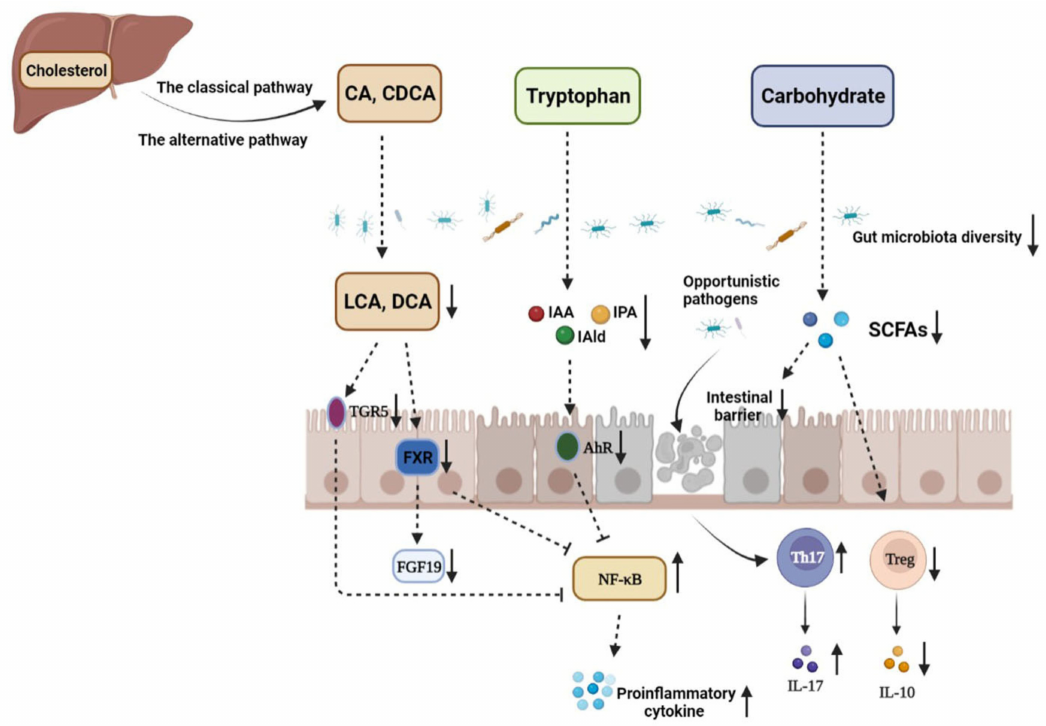
Figure 1. The disturbance of gut microbiota and microbiome metabolites in the pathogenesis of IBD. CA: cholic acid; CDCA: chenodeoxycholic acid; LCA: lithocholic acid; DCA: deoxycholic acid; TGR5: G-protein-coupled bile acid receptor 1; FXR: farnesoid X receptor; FGF19: fibroblast growth factor 19; IAA: indole-3-acetic acid; IAld: indole-3-aldehyde; IPA: indole-3-propionic acid; AhR: